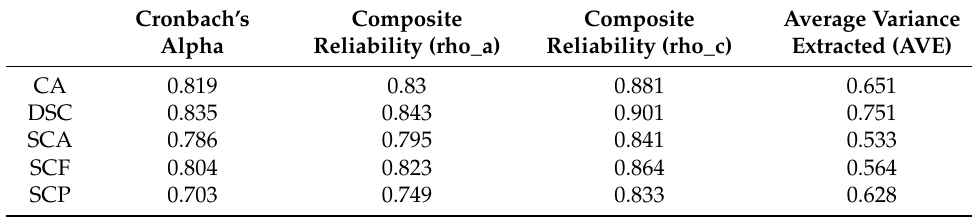
Table 1. Measurement Model.